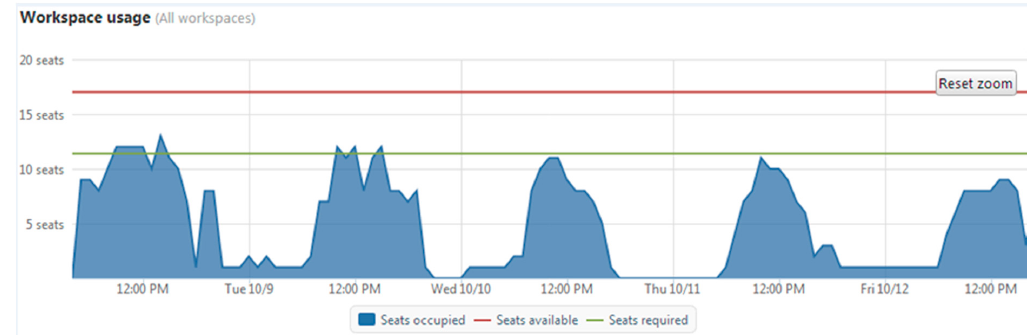
Figure 2. Results from the occupancy measurements with Wirepas. The lower horizontal line shows the seats required and the upper horizontal line represents the seats available.